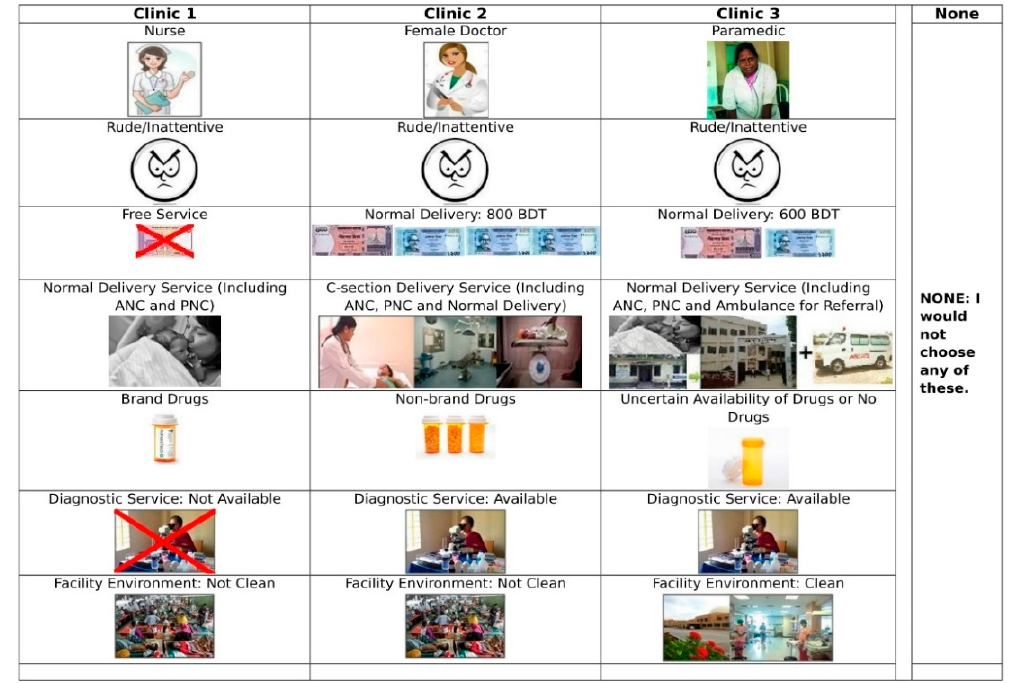
Figure 3. The hypothetical scenarios of the health facility.